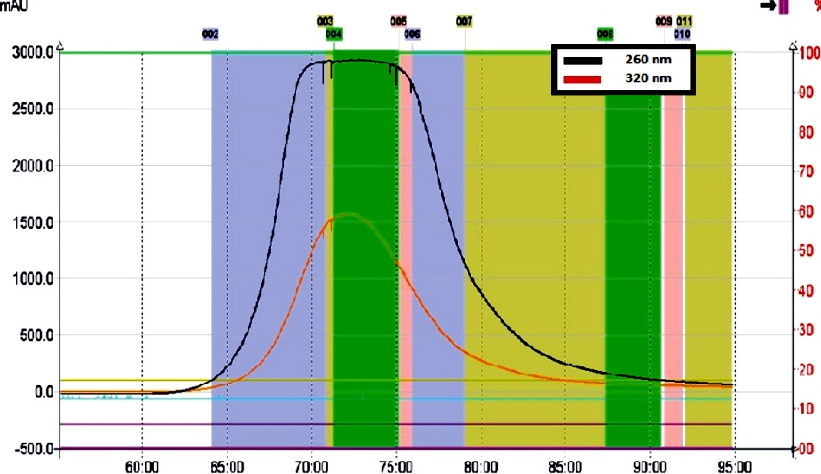
Figure 3. Chromatographic profile of polar isoflavone fraction recorded at 260 nm (black line) obtained from the kudzu root lyophilisate using the CPC method.